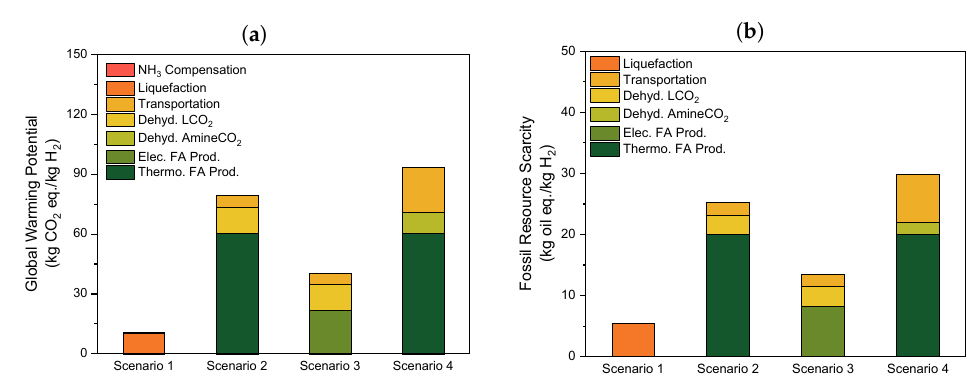
Figure 5. The LCA results of the four scenarios, regarding ( a ) GWP values and ( b ) FRS values.